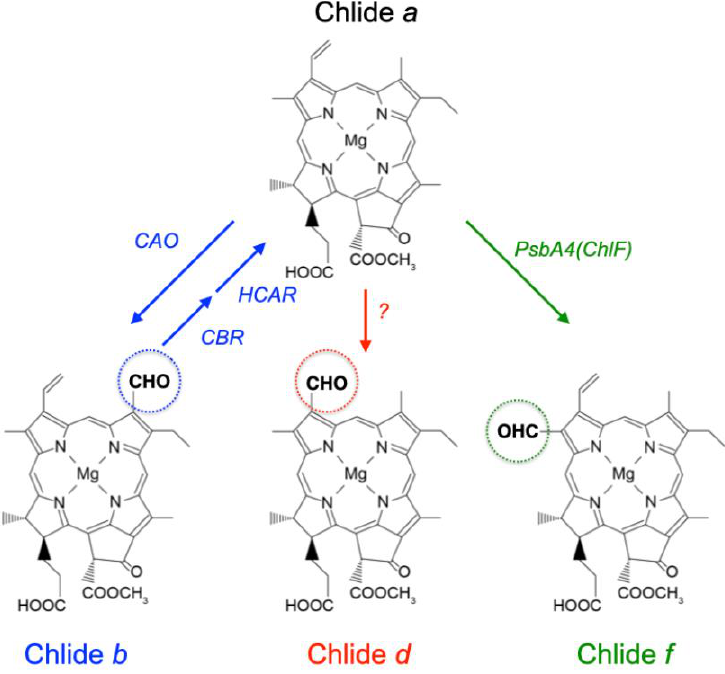
Figure 1. Chl a derivatives. Chl metabolic pathways for Chl b , d , and f from Chl a . The dashed circle indicates modified position and arrows indicate each of the following enzymatic reactions. CAO; chlorophyllide a oxygenase, CBR; Chl b reductase, HCAR; 7-hydroxymethyl Chl a reductase.